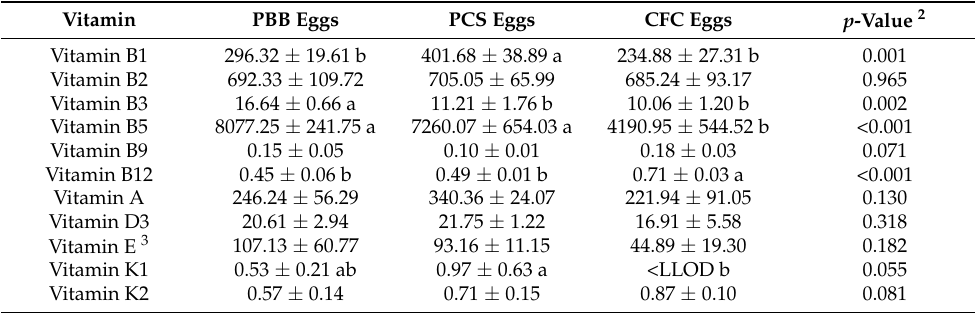
Table 7. Vitamin profile of the egg yolks ( µ g/100 g fresh yolk) 1 . Vitamin